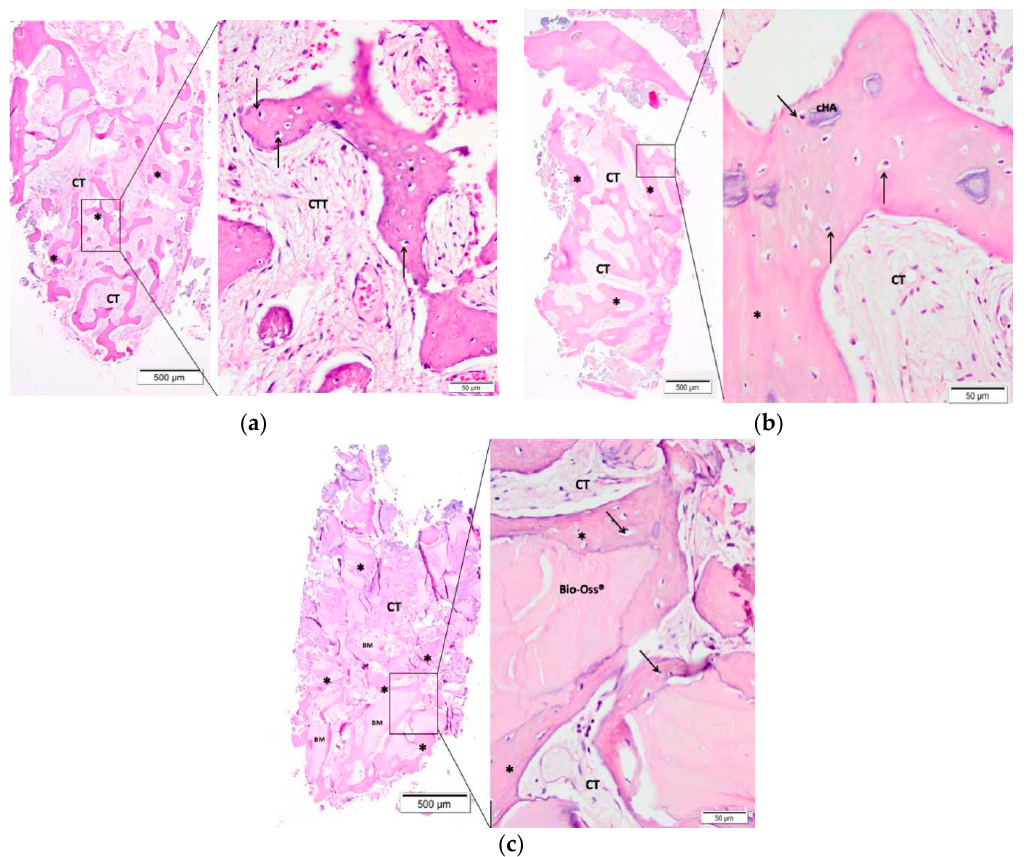
Figure 3. Representative photomicrographs of the alveolar socket after 90 days of biomaterial implantation: ( a ) Control group (Clot), ( b ) CHA group, and ( c ) Bio-Oss ® group. The small squares are displayed at 40-fold magnification adjacent to the figures with lower magnification. Connective tissue (CT); (*) new bone formation; osteoblast pavement (black arrow); carbonated hydroxyapatite (CHA) and Bio-Oss ® . Hematoxylin and